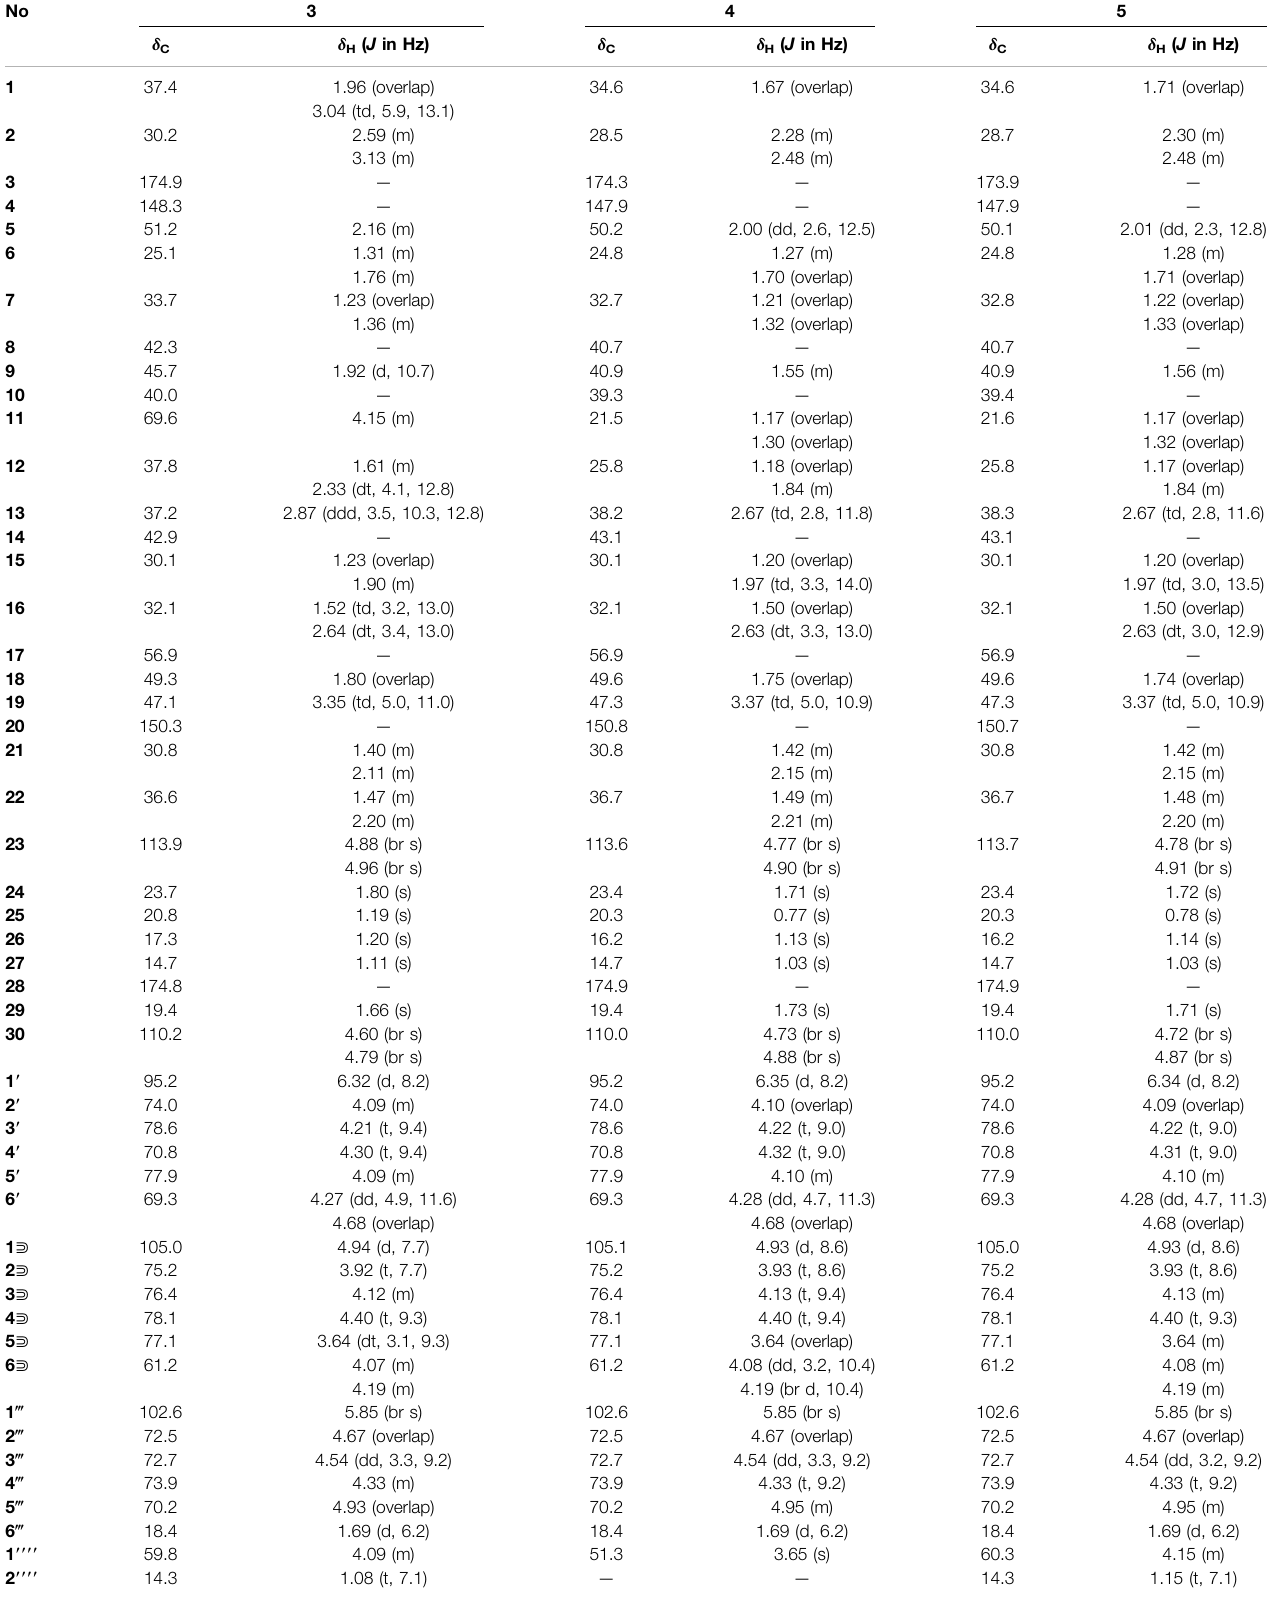
TABLE 2 | 1 H (600 MHz) and 13 C NMR (150 MHz) data in pyridine- d 5 for 3 – 5